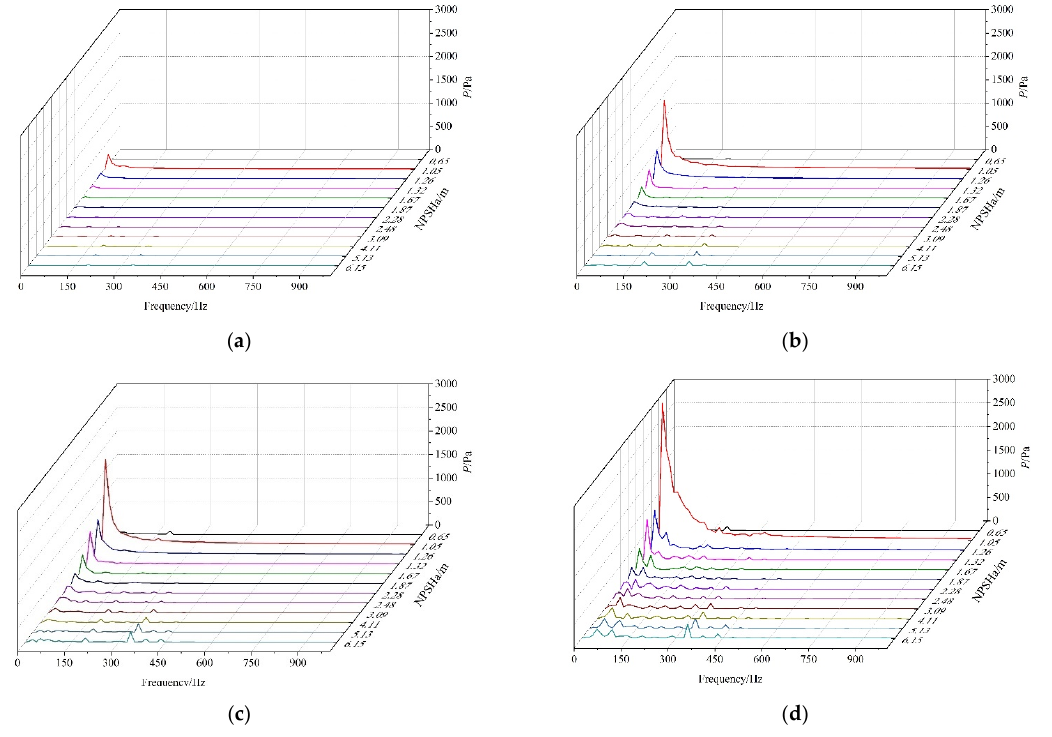
Figure 12. Frequency properties of four monitoring points at different NPSHa: ( a ) p1; ( b ) p2; ( c ) p3; ( d ) p4.